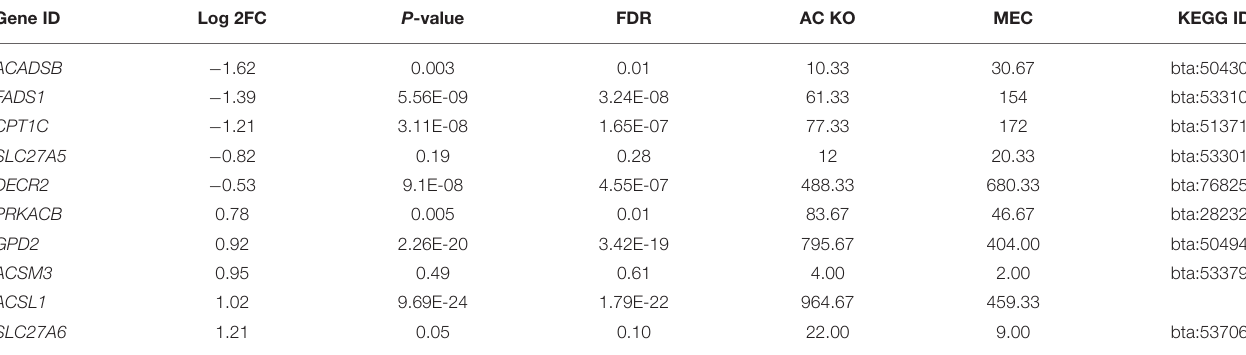
TABLE 1 | The expression levels details of partial regulated genes in ACADSB − / − bMECs .